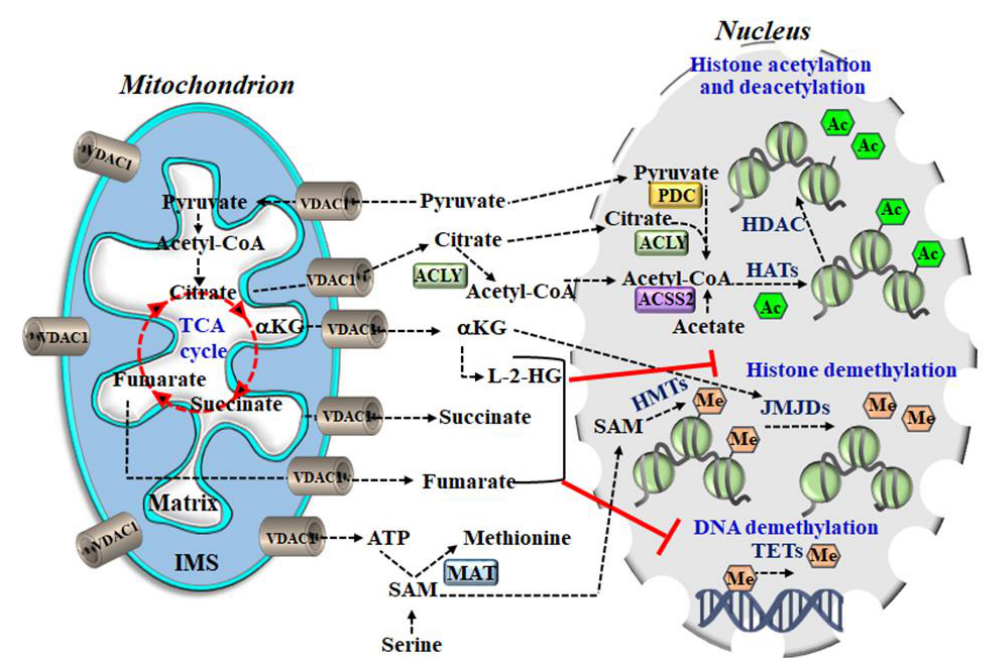
Figure 4. Mitochondrial metabolites are transported by VDAC1 to the cytosol and are then Figure4. MitochondrialmetabolitesaretransportedbyVDAC1tothecytosolandarethentransportedto transported to the nucleus where they serve as substrates for enzymes that modify chromatin. the nucleus where they serve as substrates for enzymes that modify chromatin. Mitochondrial metabolic pathways including the TCA cycle generate substrates required for the methylation, acetylation, or demethylation reactions that modify chromatin. Specifically, histone acetylation by histone acetylation by histone acetyltransferases (HATs) is dependent on the availability of acetyl groups acetyltransferases (HATs) is dependent on the availability of acetyl groups provided by acetyl-CoA, which is produced in the cytosol by ACLY using citrate exported from the TCA cycle in mitochondria. α -ketoglutarate ( α -KG) is an essential co-factor of 2-oxoglutarate-dependent dioxygenases (2-OGDD), including the histone demethylases Jumonji domains (JMJDs) and ten-eleven translocations (TETs), which are DNA demethylases. Succinate is the product of 2-OGDD enzyme reaction; thus, when it accumulates, it works as an antagonist of the reaction. Moreover, 2-Hydroxyglutarate (2-HG) and fumarate can also rewire the epigenetic landscape of the cells through inhibition of histone and DNA demethylation. The metabolites cross the IMM via specific transporters, and cross the OMM via a single protein VDAC1. The metabolites directly relevant to chromatin regulation reach the nucleus where several metabolic enzymes are localized including: methionine adenosyl-transferase (MAT); ATP-citrate lyase (ACLY), which catalyzes the ATP-dependent cleavage of mitochondrial-derived citrate into oxaloacetate; acetyl-CoA; pyruvate dehydrogenase complex (PDC); and acetyl-CoA synthetase 2